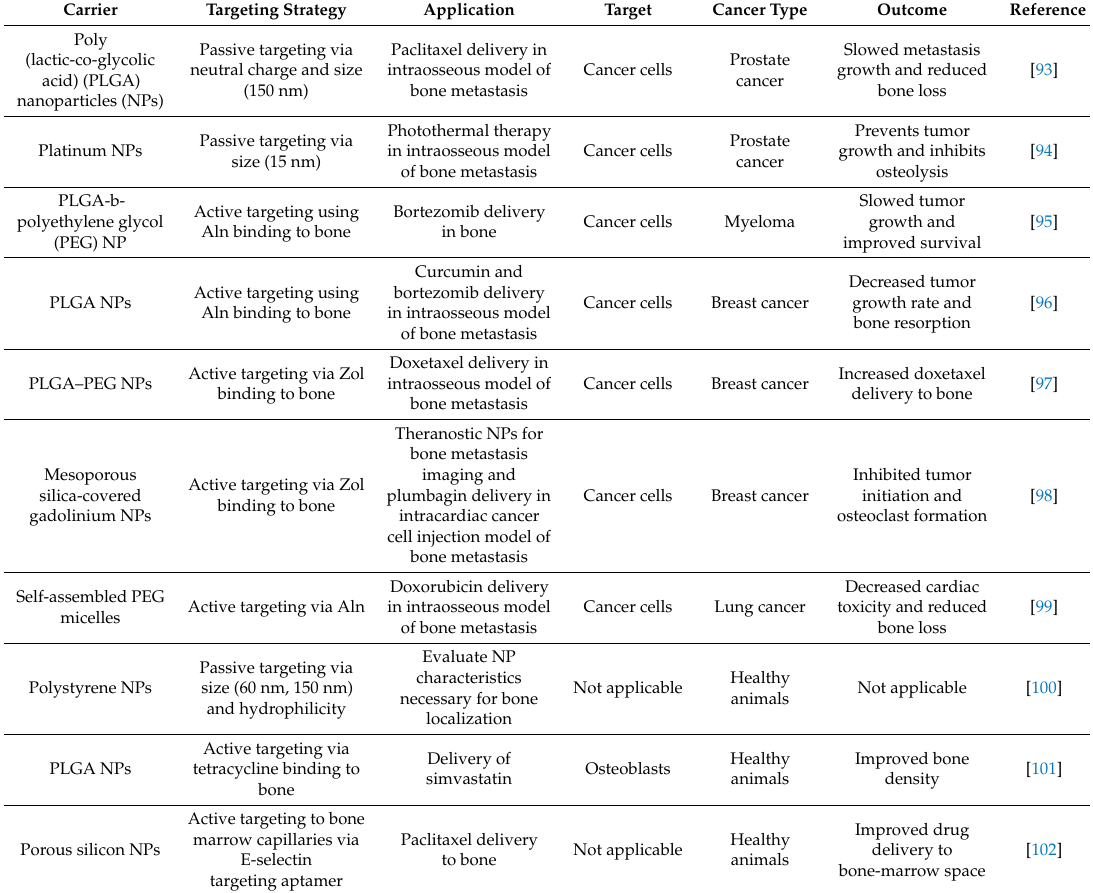
Table 3. Targeting strategies and applications of bone-targeted drug-delivery